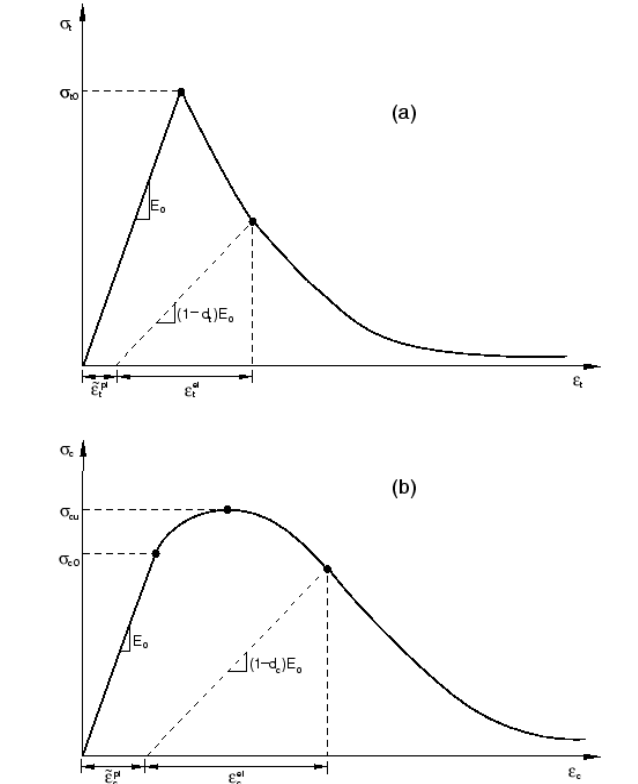
Fig. 3. Concrete response in uniaxial tensile (a) and (b) Compressive loading (ABAQUS software help). Which this continuous effective stress indicates the surface yield (or